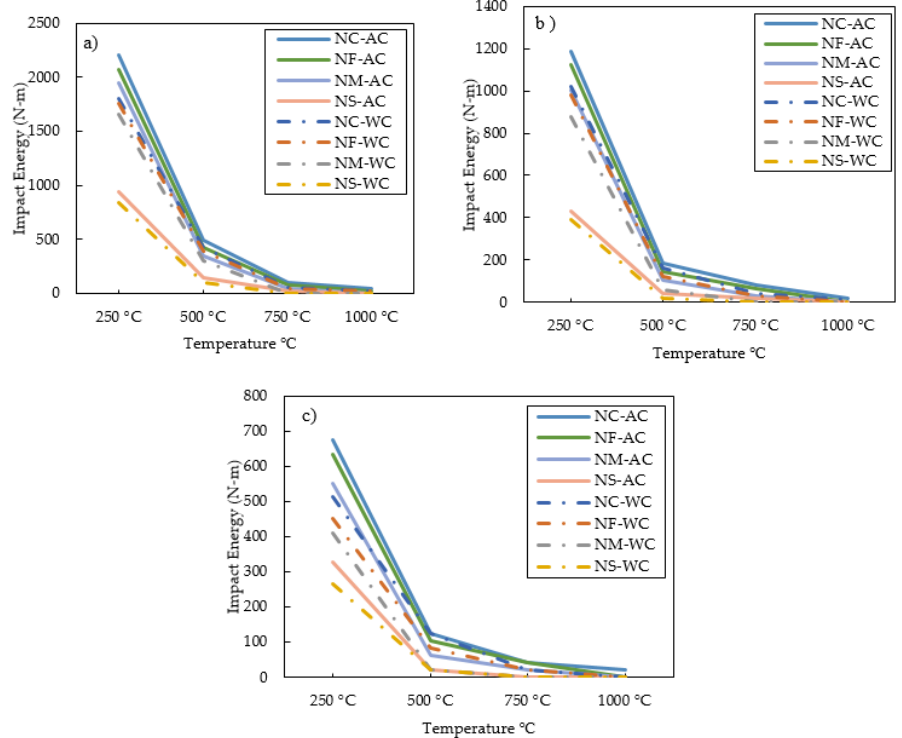
Figure 5. Impact energy versus temperature of M40 grade concrete with various percentages of nanomaterials: ( a ) 10%; ( b ) 20%; ( c ) 30%.